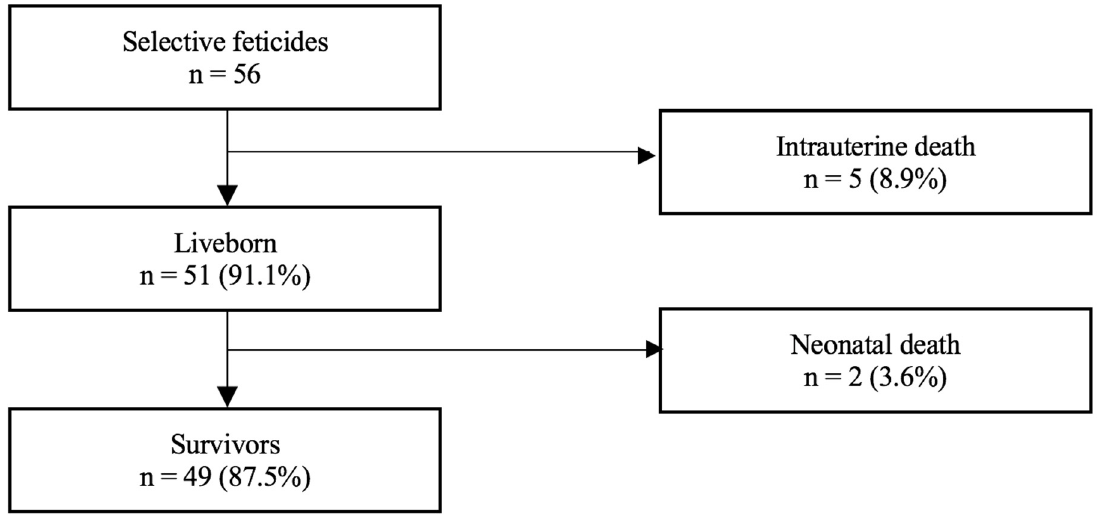
Figure 3. Mortality rate of 56 monochorionic cases that underwent selective feticide.